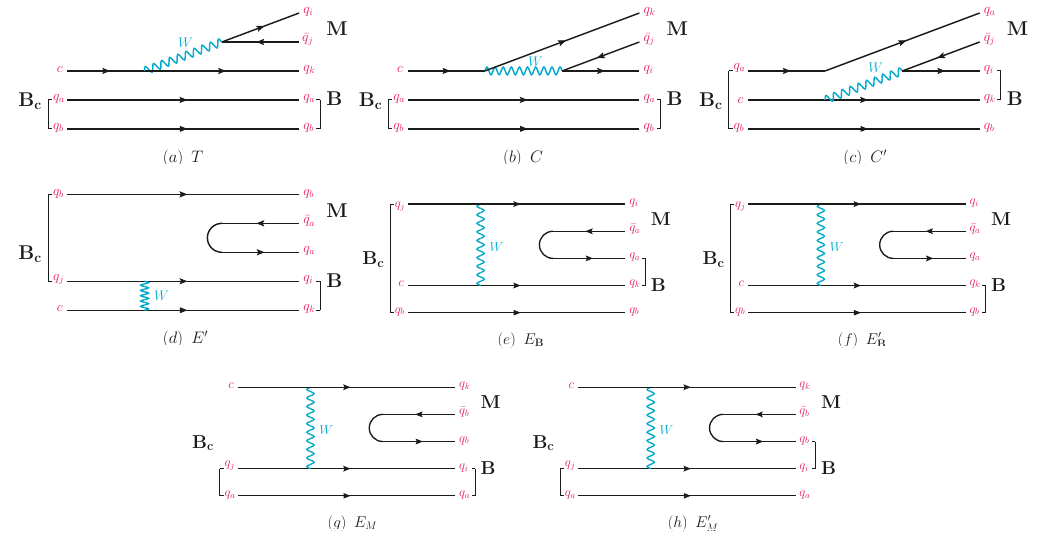
Figure 1 . Topological diagrams for the B c → B M decays, where the notations “[” and “]” denote the anti-symmetric quark orderings of the anti-triplet charmed and octet baryon states,